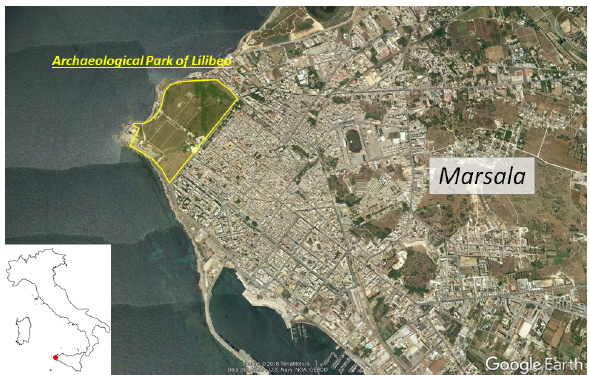
Figure 1. Archaeological Park of “Lilibeo” (from Google